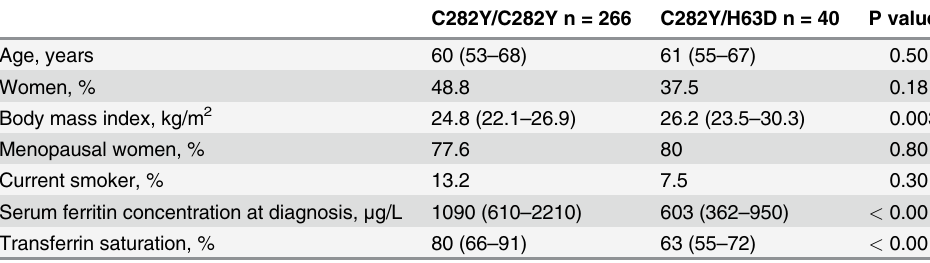
Table 1. Characteristics of patients with hereditary hemochromatosis by